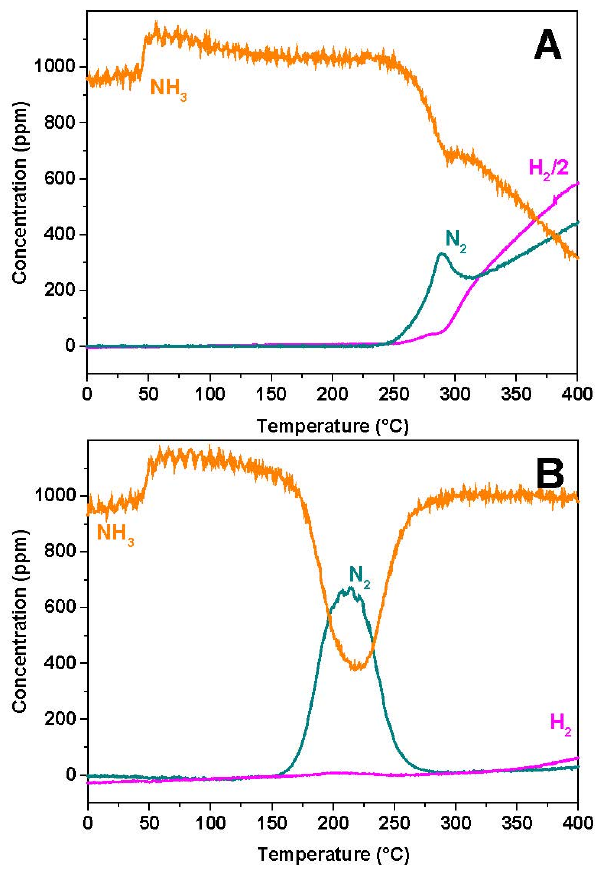
Figure 9. NH 3 ‐ TPSR experiments with NH 3 (1000 ppm) from 40–400 °C (4 °C/min) after NO/O 2 Figure 9. NH 3 -TPSR experiments with NH 3 (1000 ppm) from 40–400 ˝ C (4 ˝ C/min) after NO/O 2 adsorption at 350 °C over: ( A ) Rh ‐ BaO/Al 2 O 3 and ( B ) Pt ‐ BaO/Al 2 O 3 (rig#3). adsorption at 350 ˝ C over: ( A ) Rh-BaO/Al 2 O 3 and ( B ) Pt-BaO/Al 2 O 3